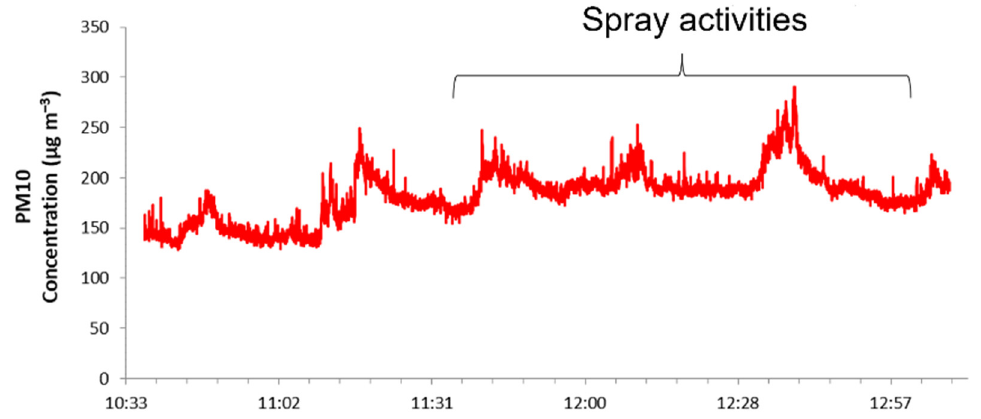
Figure 10. Temporal trend of particle mass concentrations, in terms of PM10, measured by means of DustTrack II at far field.